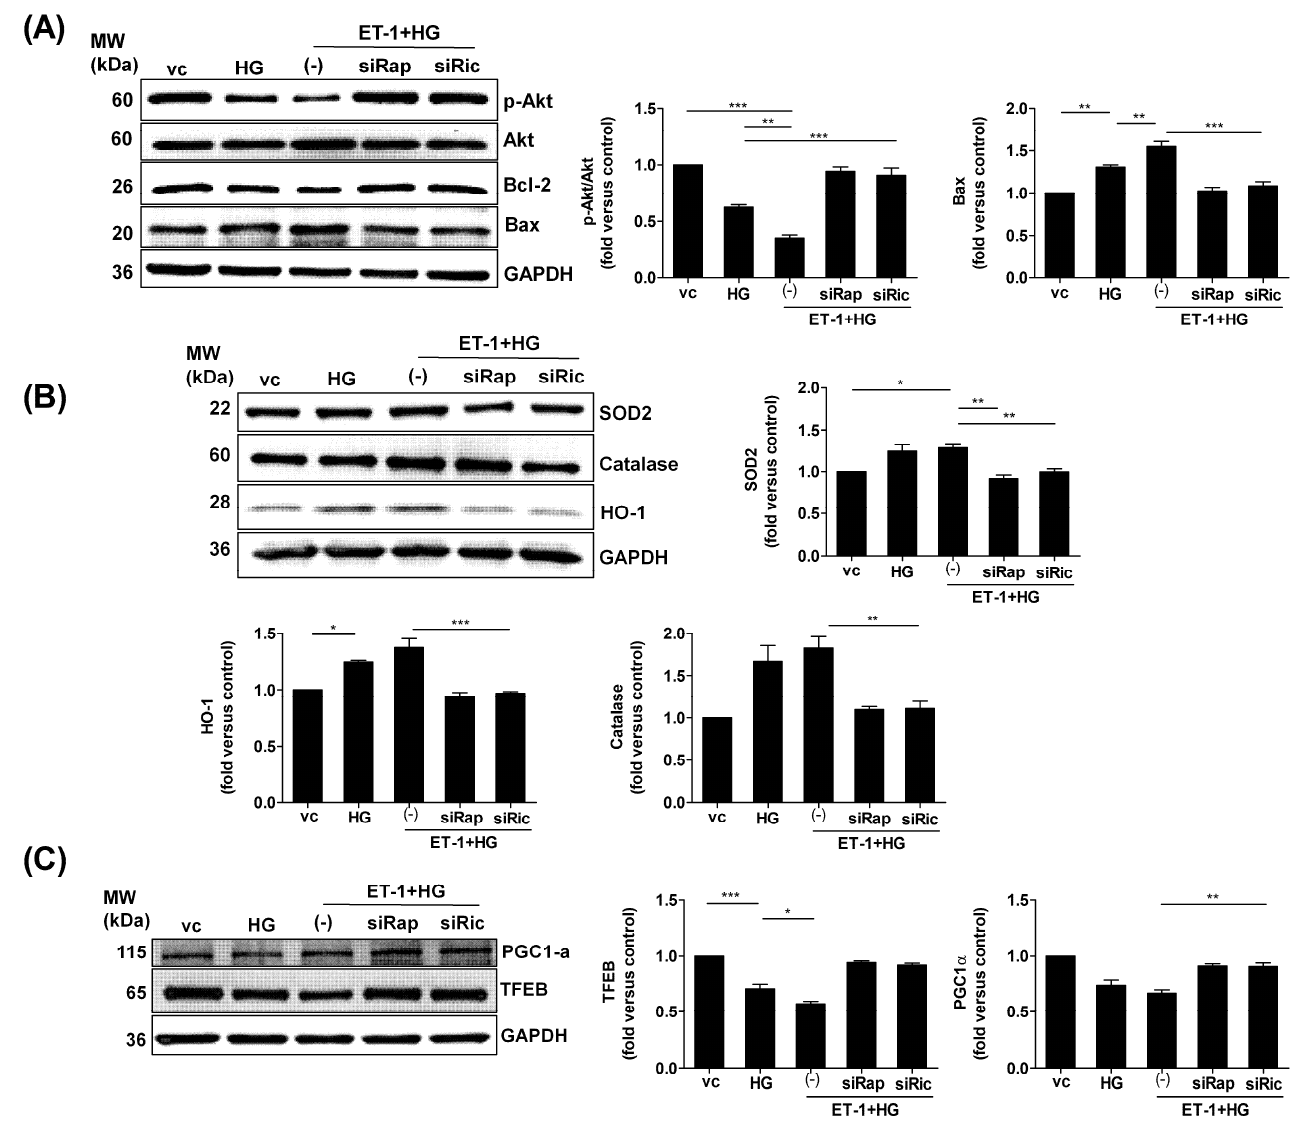
Figure 3. Inhibition of mTOR improved the survival markers in HG-treated H9c2 cells. The H9c2 cells were seeded in low glucose medium overnight. Next, the cells were transfected with siRNAs against Raptor/Rictor for 24 h, followed by ET-1 (20 nM) treatment for 3 h and by HG treatment for another 24 h. Protein expressions of survival/apoptosis markers p-Akt, Bcl-2, and Bax ( A ); antioxidant markers SOD2, catalase, and HO-1 ( B ); and mitochondrial/autophagy marker PGC1 α and TFEB ( C ) were determined using western blot. Protein densitometry analysis was done using Image J software (NIH). N = 3; Mean ± S.E.M.; * p < 0.05, ** p < 0.01, *** p < 0.001.